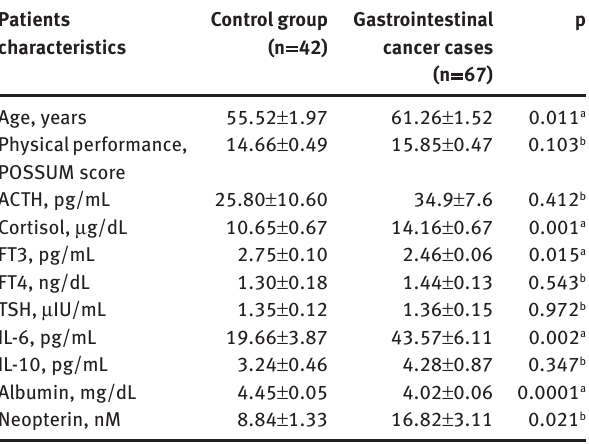
Table 2: Characteristics of 109 patients and evaluation of gastroin- testinal cancer cases vs. control subjects at diagnosis.